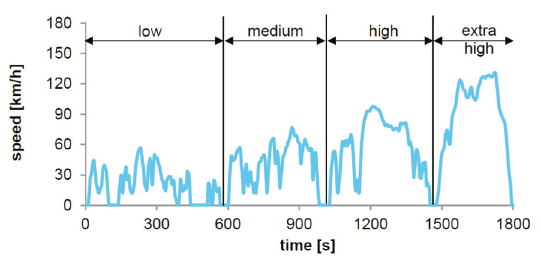
The first NEDC of each test series was performed with cold start (20-25°C) and further cycles followed with warm engine. Between the cycle always 3 minutes of constant speed 80 km/h in 4 th gear were performed as conditioning. The braking resistances were set according to legal prescriptions they were not increased i.e. responded to the horizontal